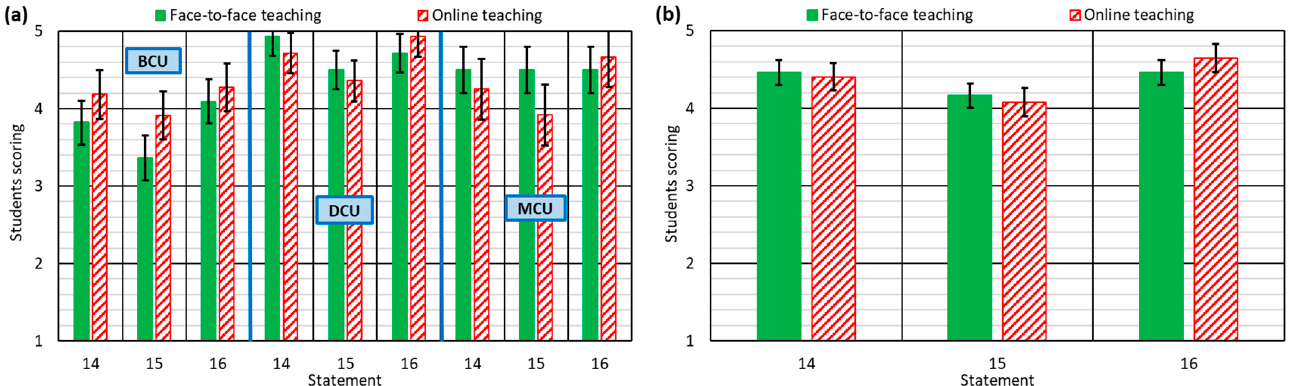
Figure 5. Student responses to statements 14–16: ( a ) for each type of course unit; ( b ) for all course units.